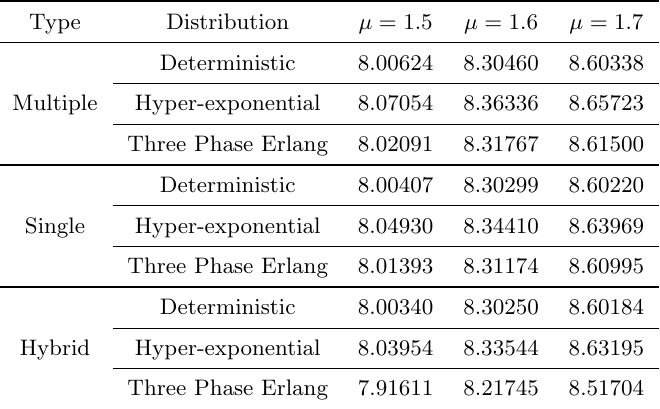
l queueing systems with three types of service